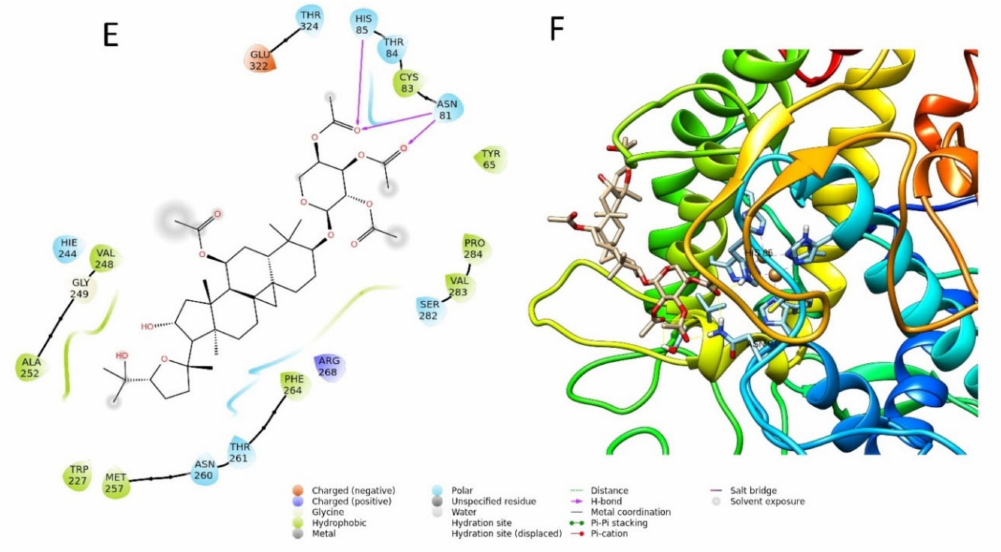
Figure 6. Two-dimensional and three-dimensional docking poses of compound 2 ( A , B ), compound 6 ( C , D ), and compound 7 ( E , F ).